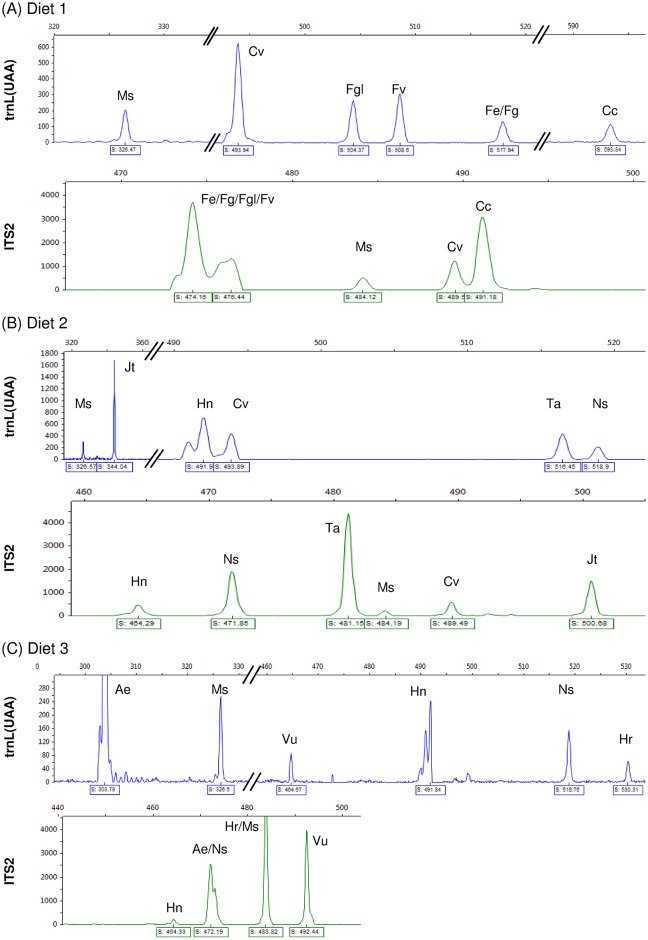
Electropherograms peaks of the three controlled diets offered to the stabled Pyrenean chamois, obtained by capillary electrophoresis of the fluorescence labelled PCR products corresponding to trnL(UAA) (blue) and ITS2 (green) multiplex amplification.For a better interpretation, the two fluorescence channels are shown separately. Plant species initials are as in Table 1.